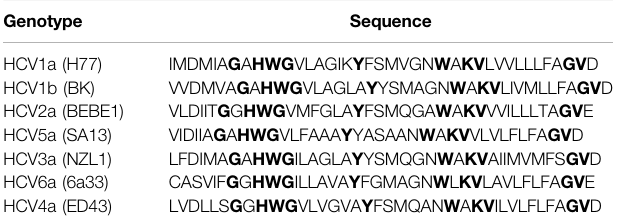
TABLE 7 | Alignment of segment (344 – 382) from various genotypes of HCV. In bold are represented the fully conserved residues. In red and blue are the pre- anchor domain and transmembrane region respectively.